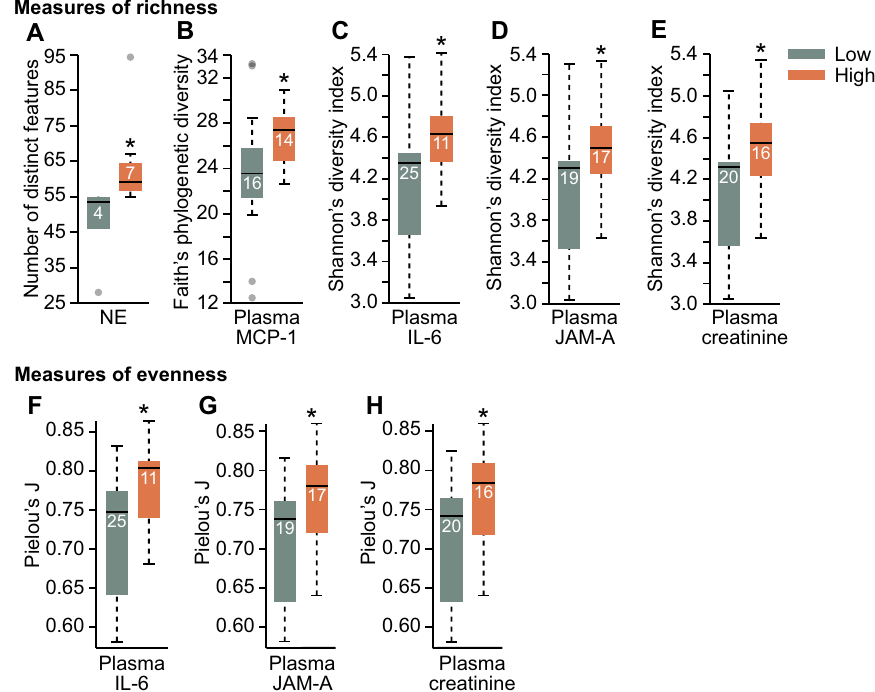
Figure 2. Maintenance of blood pressure, as measured by total norepinephrine (NE) administered, and several plasma measures of inflammation and membrane damage are associated with elevated levels of microbial alpha diversity. (A) Number of distinct features, a metric of richness, against low or high total NE (µg) required for maintenance of an appropriate blood pressure following polytrauma (PT) + hemorrhagic shock (HS), or HS alone, (B) Faith’s phylogenetic diversity against low or high plasma monocyte chemoattractant protein-1 concentration (MCP-1, pg/ml), (C) Shannon’s diversity index against low or high plasma interleukin-6 concentration (IL-6, pg/ml), (D) Shannon’s diversity index against low or high plasma junctional adhesion molecule A concentration (JAM-A, pg/ml), (E) Shannon’s diversity index against low or high plasma creatinine concentration (pg/ml), (F–H) Pielou’s J’ against (F) low or high plasma IL-6 concentration (pg/ml), (G) low or high plasma JAM-A concentration (pg/ml), and (H) low or high plasma creatinine concentration (pg/ ml). The bottoms and tops of boxes indicate the first and third quartiles, respectively; whiskers indicate the 1.5 interquartile range beyond the upper and lower quartiles. Values outside the whiskers are indicated by gray circles; numbers in each box indicate sample sizes. Statistical significance in each categorical variable was evaluated using Kruskal–Wallis ranks-sums tests with post hoc pairwise Mann–Whitney U tests at p < 0.05. * p < 0.05; HS hemorrhagic shock, IL-6 interleukin 6, IQR interquartile range, JAM-A junctional adhesion molecule A, MCP-1 monocyte chemoattractant protein-1, NE norepinephrine, PT